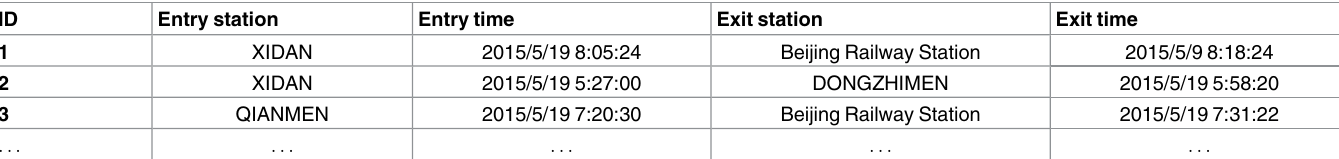
Table 1. Example of smart card